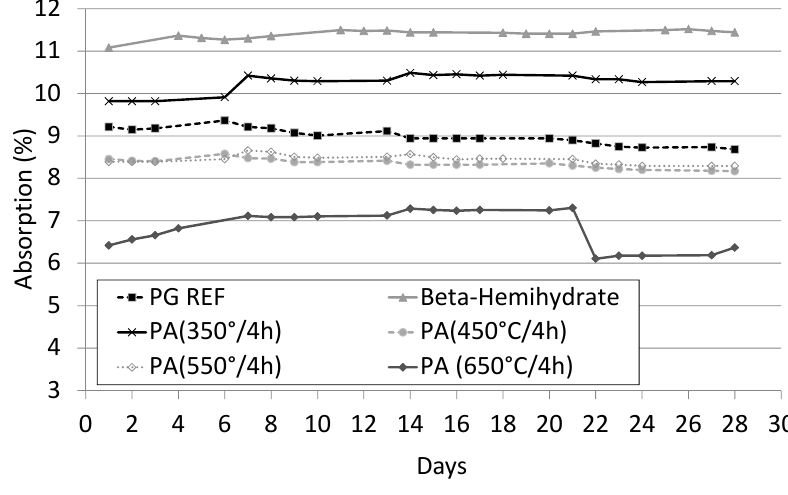
Figure 8. Absorption of water by SLUs during the immersion test.